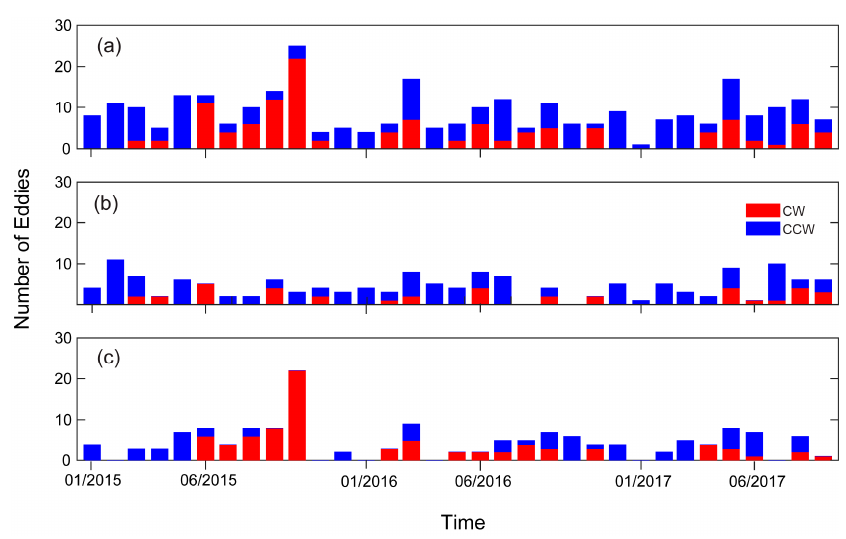
Figure 13. Time series of monthly number of days with eddies over the period January 2015 to September 2017: ( a ) total for the study region; ( b ) for the region north of north of 31.5 ◦ S; and ( c ) for the region south of 31.5 ◦ S. Blue and red bars represent counterclockwise (CCW) and clockwise (CW) eddies